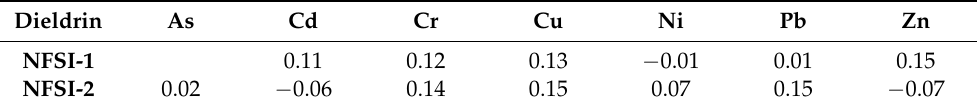
Table 5. Correlation coefficients between Dieldrin concentration and the As, Cd, Cr, Cu, Ni, Pb and Zn concentrations in the humus layers of Brandenburg NFSI sites differentiated for data from NFSI-1 (n = 36) and NFSI-2 (n =